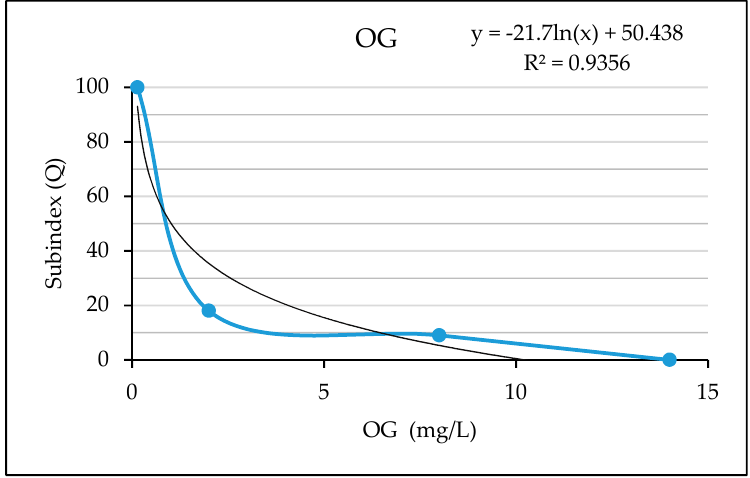
Figure 3. Sub-index values of OG.